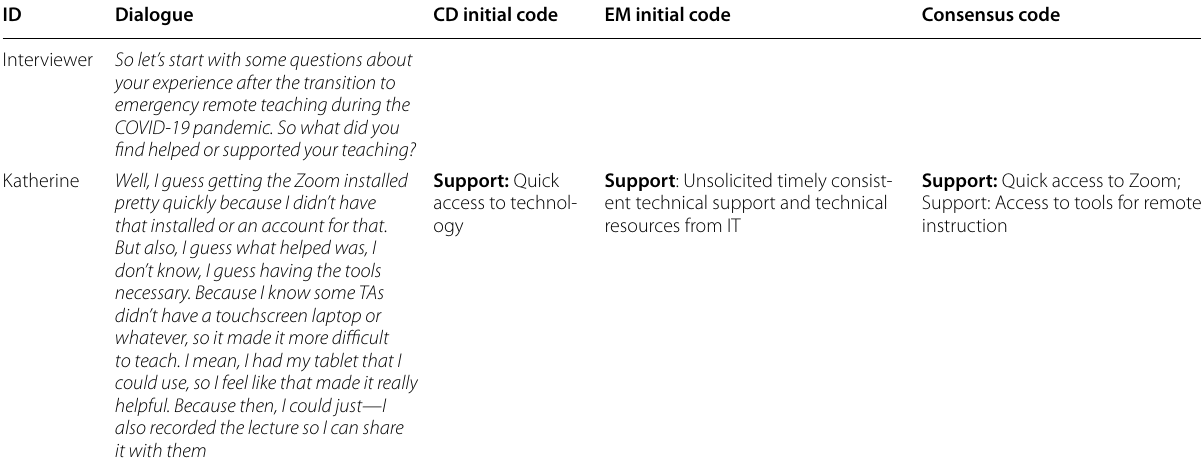
Table 5 Second (axial) cycle consensus coding with support example